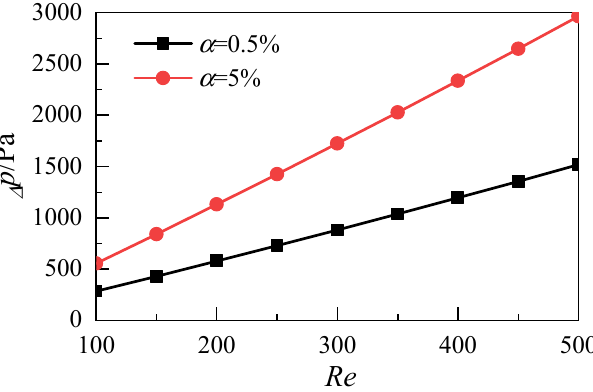
Figure 7. Influence of nanoparticle volume fraction on pressure difference.